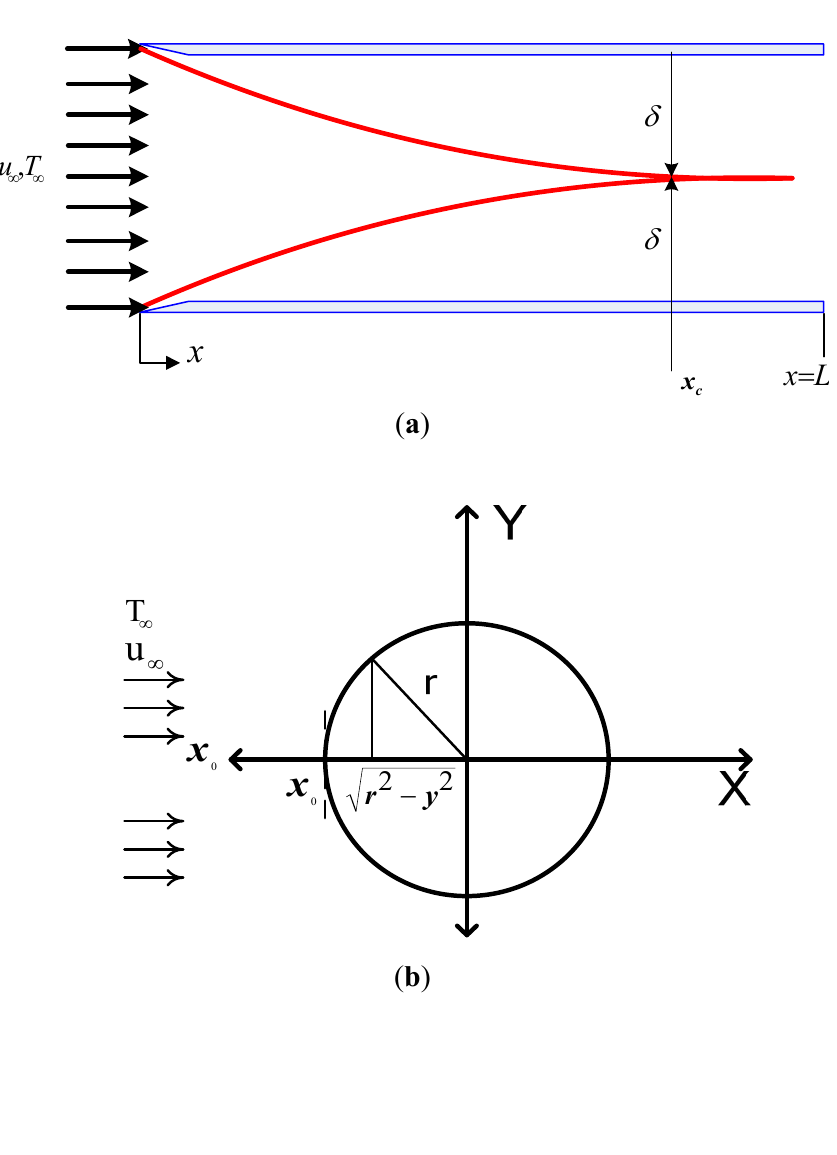
Figure 3. Boundary layer of the round plate fins. ( a ) Schematic of the boundary layer between the fins; ( b ) Configurations of the round plate